Question: Name the type of graph shown.
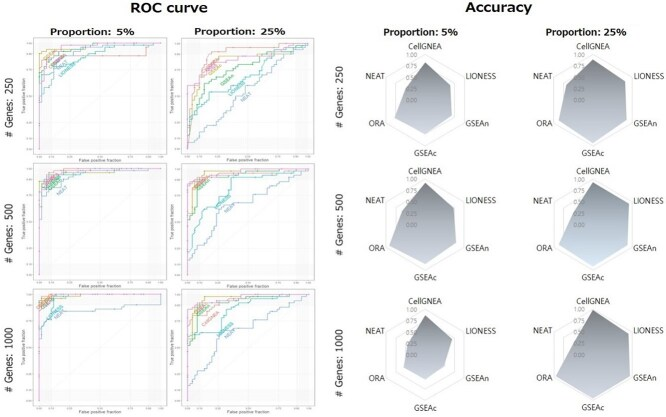
Answer: line